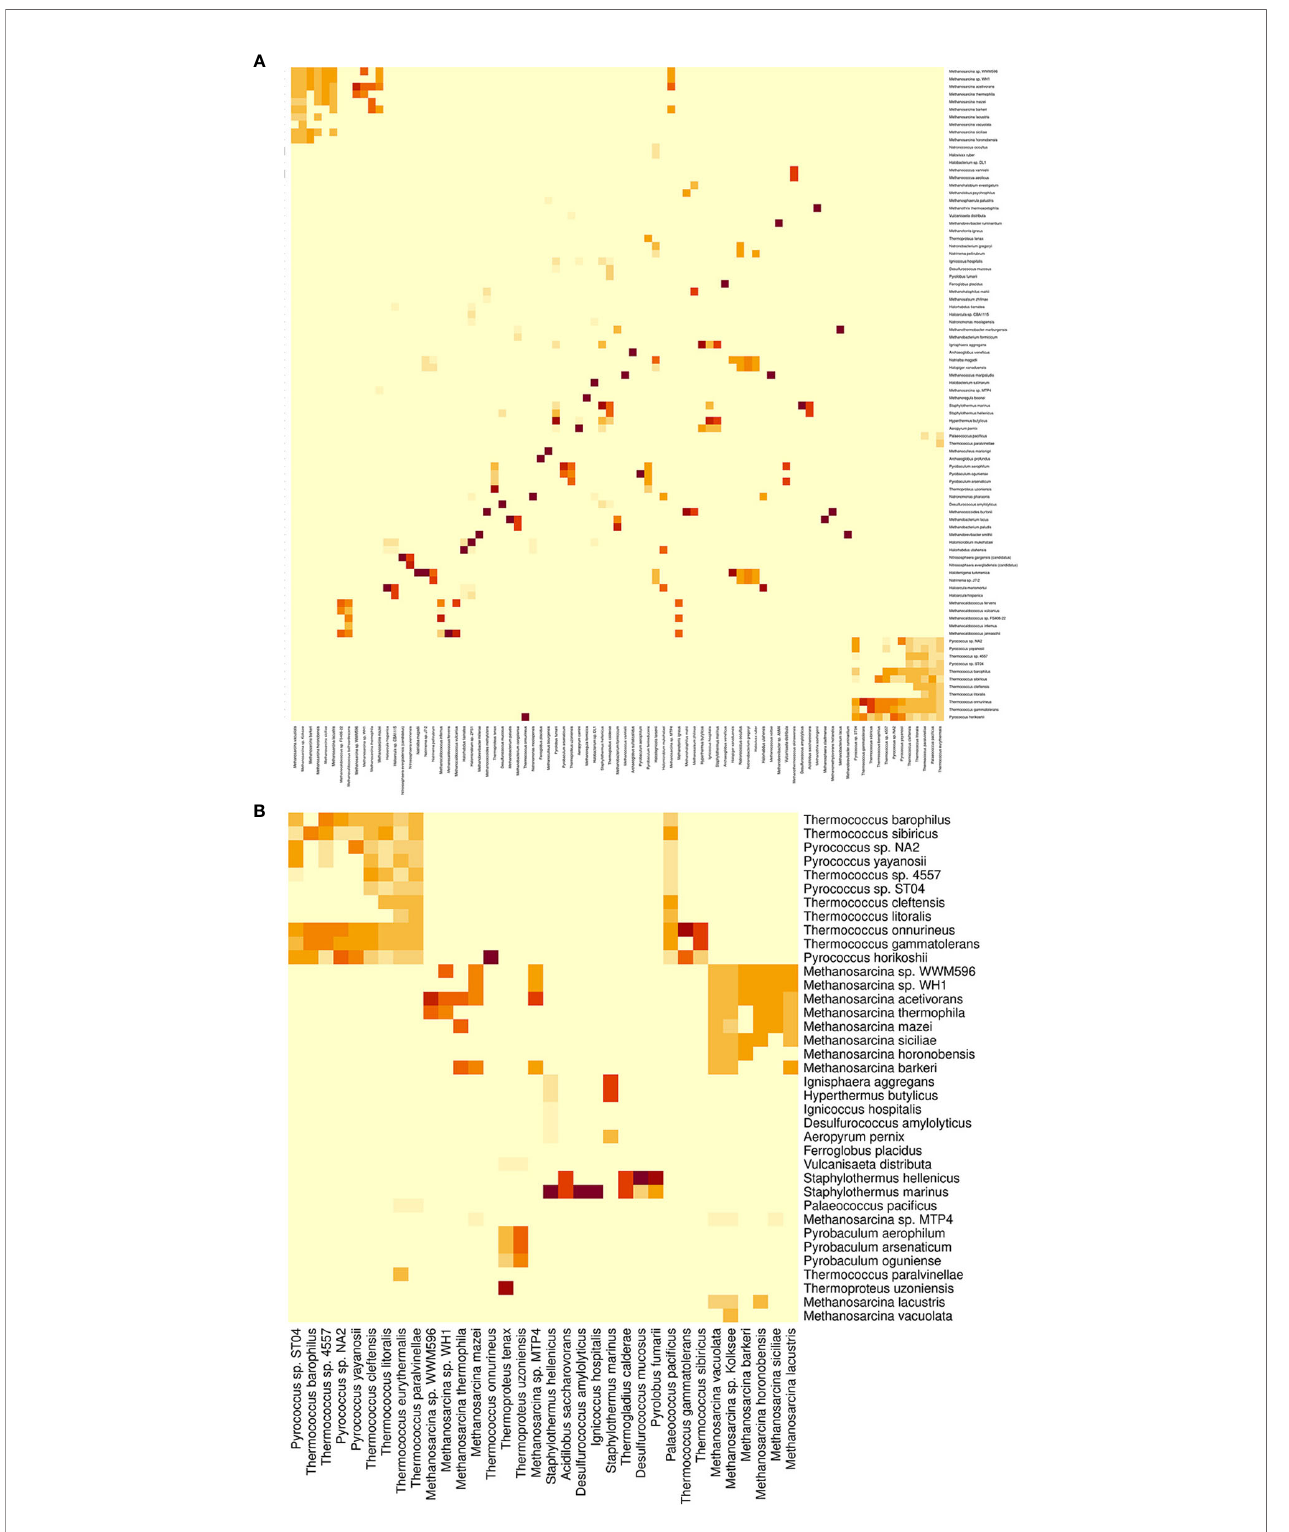
FIGURE 8 | Heat map showing the presence of in-silico amplicon similarity values ≥ 97% between pairs of different bacterial species. (A) Global perspective. (B) Partial perspective, involving species belonging to genera Staphylococcus , Streptococcus , Tannerella , and Treponema . The intensity of the color indicates the frequency, i.e. the number of times a species pair had an in-silico amplicon similarity value ≥ 97% in the different primer pairs